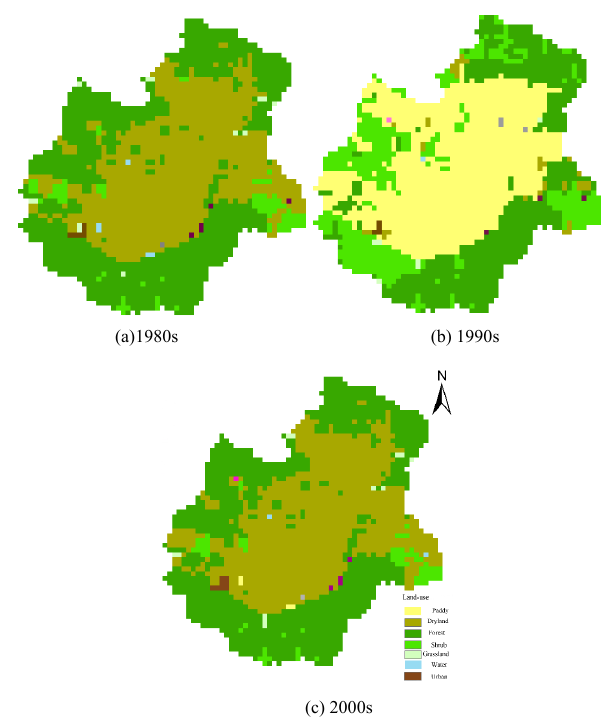
Figure 2. Land-uses in three-phrases in the upper Huaihe River above the Dapoling